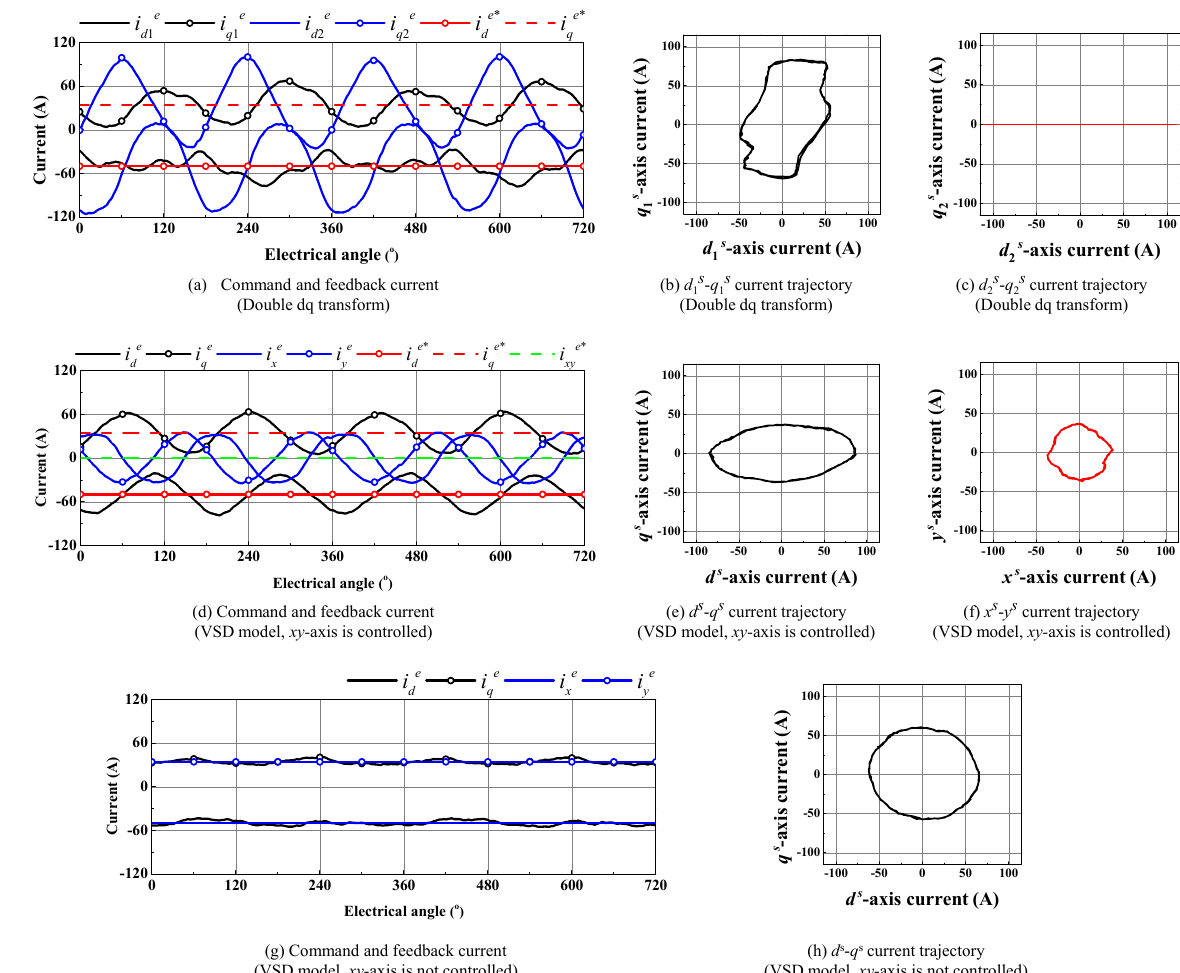
Figure 11. ( a – h ) Experiment results of rotational coordinate command, feedback currents, and stational coordinate current trajectory when applying to the Double dq transform and VSD model (current waveform when xy -axis is controlled and when not controlled).